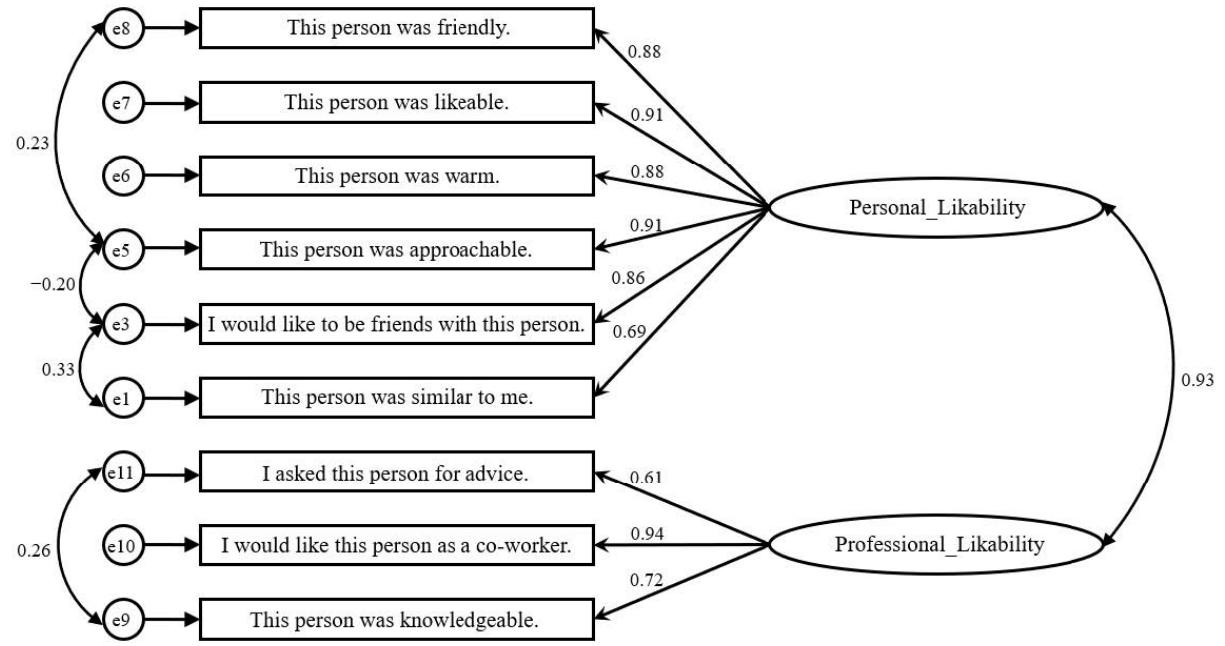
Figure 2. The CFA Model of the Construct of Likability. Based on the final CFA model, we computed the mean scores of personal likability and professional likability. Each of the variables had four univariate outliers, which were later capped at 3.29 standard deviations from the mean. The distributions of these variables were not